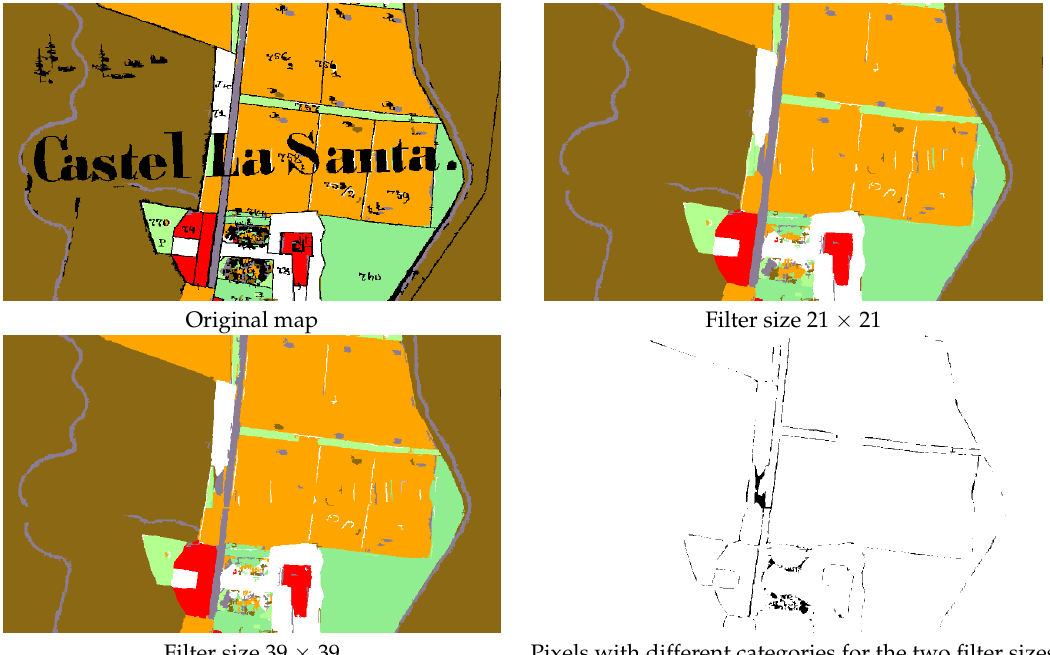
Figure 14. Output difference between 21 × 21 and 39 × 39 filter sizes: original map, output for the 21 × 21 and 39 × 39 filters and map of pixels with category difference between the